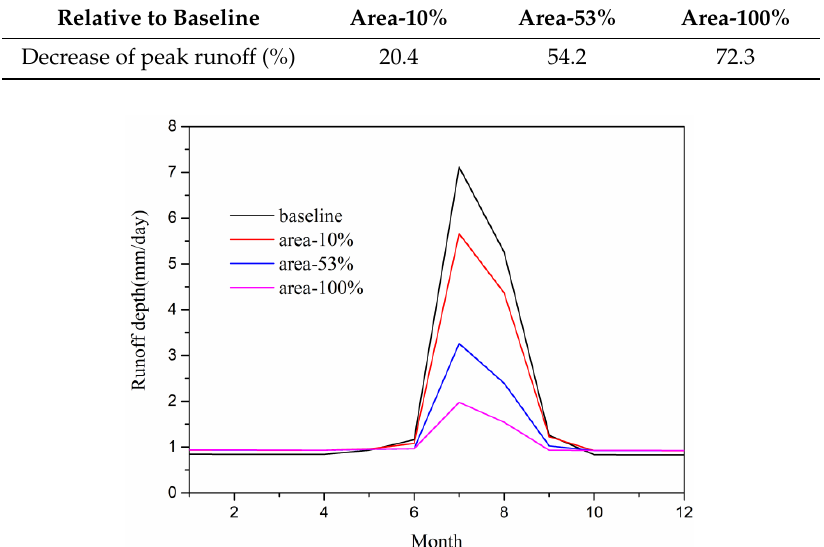
Figure 14. Sensitivity of runoff depth under different glacier area variations (1959–1961).